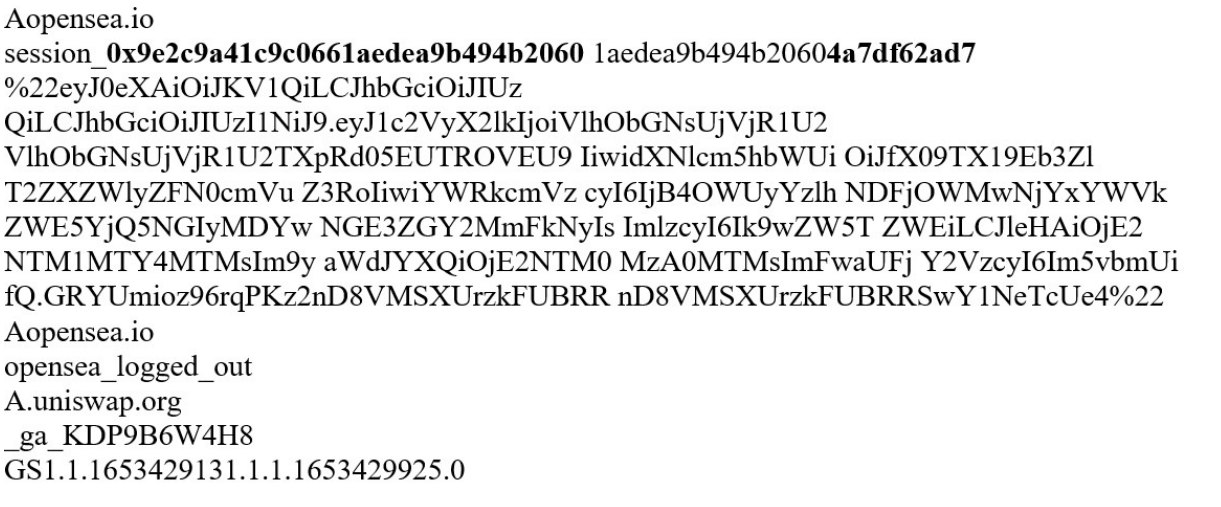
Figure 17. OpenSea.io Session ID using the wallet address , showing that the user has used this services